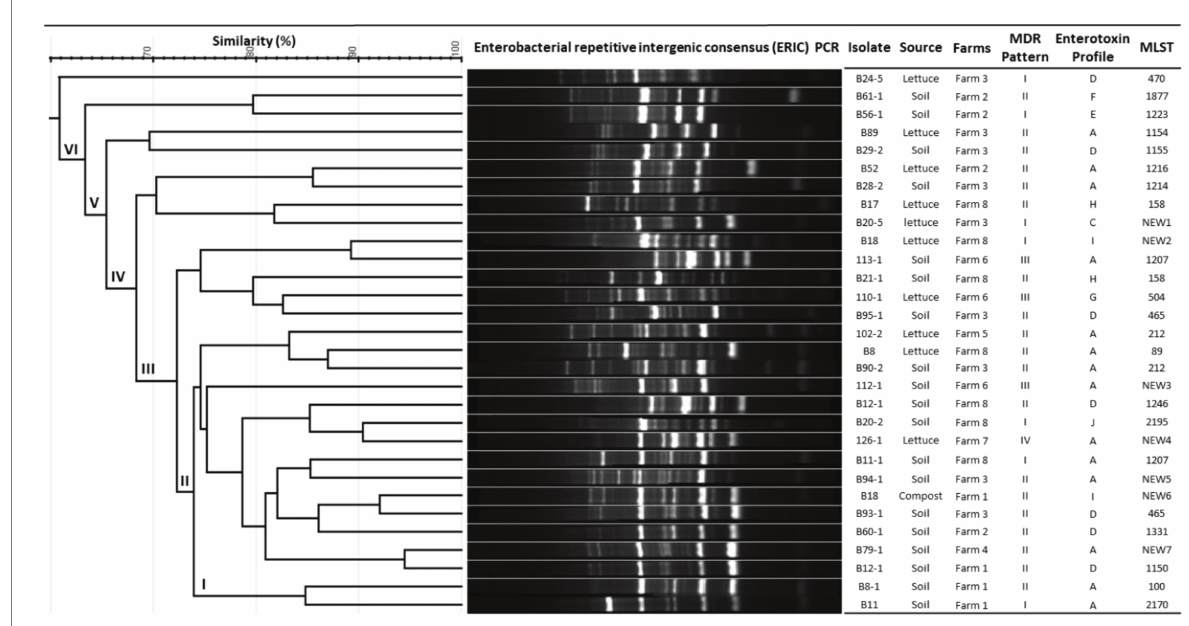
FIGURE 1 Genetic diversity analysis based on ERIC-PCR and MLST and their correlation with MDR patterns and enterotoxin profiles of Bacillus cereus isolates.